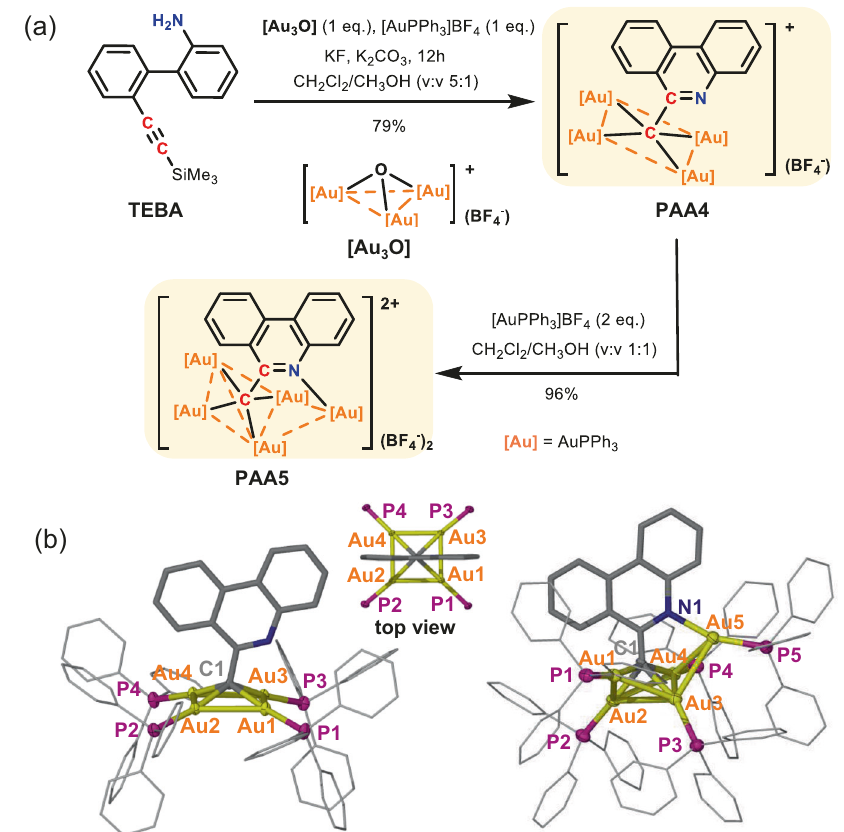
Fig. 2 | Synthesis and crystal structures of PAA4 and PAA5. a Synthetic proce- dures for PAA4 and PAA5 . b Crystal structures of PAA4 (left) and PAA5 (right). Hydrogen atoms and tetra fl uoroborate counter anions are omitted for clarity. Selected bond lengths (Å) and angles (°) in PAA4 : Au1-Au2 2.875(1), Au2-Au3 2.811(1), C1-Au1 2.146(4), C1-Au2 2.152(4), ∠ Au2-Au1-Au3 89.79(1), ∠ Au1-Au2-Au4